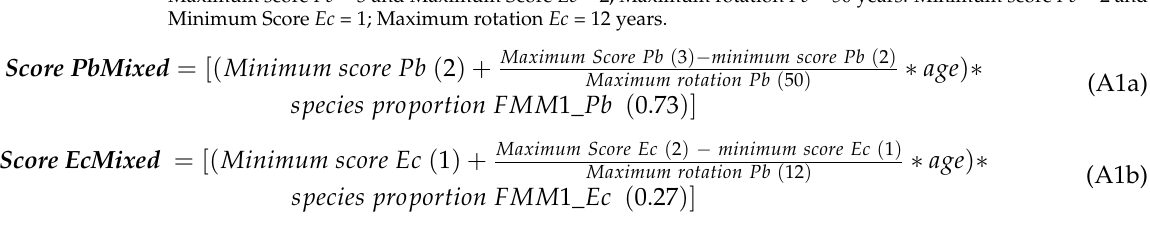
The mixed stands of maritime pine and eucalypts biodiversity range from 1 to 3 according to the dominance of eucalypt and pine, respectively